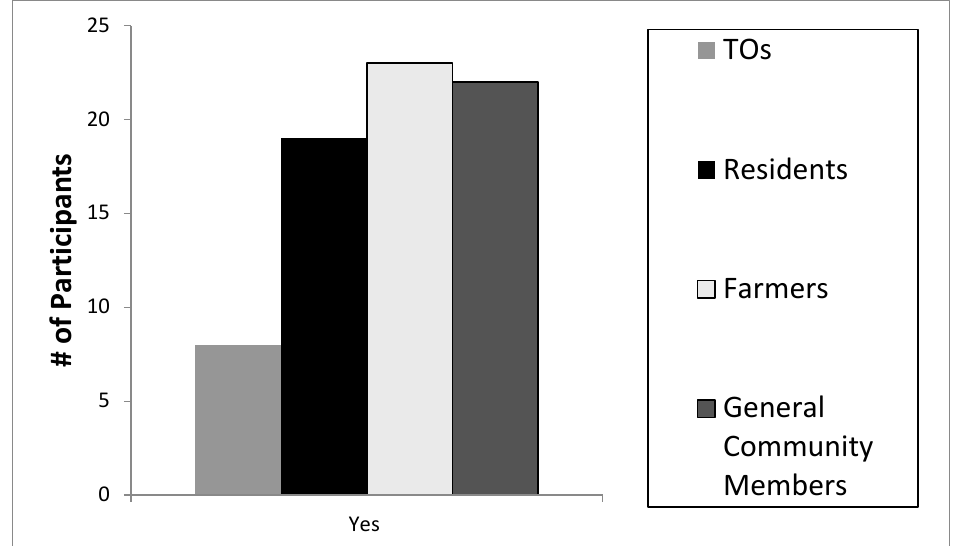
Figure A11. Knowledge of basin water quality monitoring programs. Water 2020 , 12 , x FOR PEER REVIEW